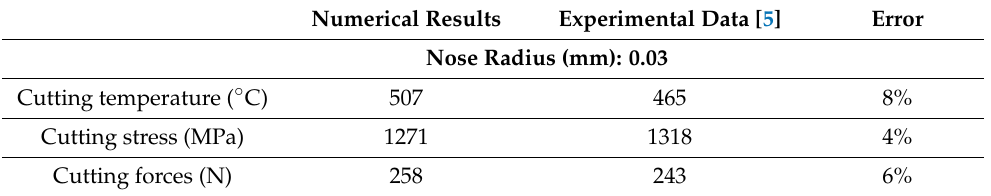
Table 4. Comparison of numerical and experimental results for small tool nose radius.